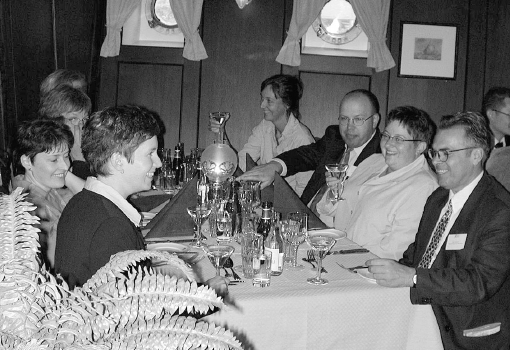
Figure 1 (left): from left to right back: Peter Szabo, Mats Stading, Antal Boldizar front: Evan Mitsoulis, Rodney Rychwalski, Mrs. White, James White Figure 2 (right): Conference dinner from left to right: Susanna Edrud,